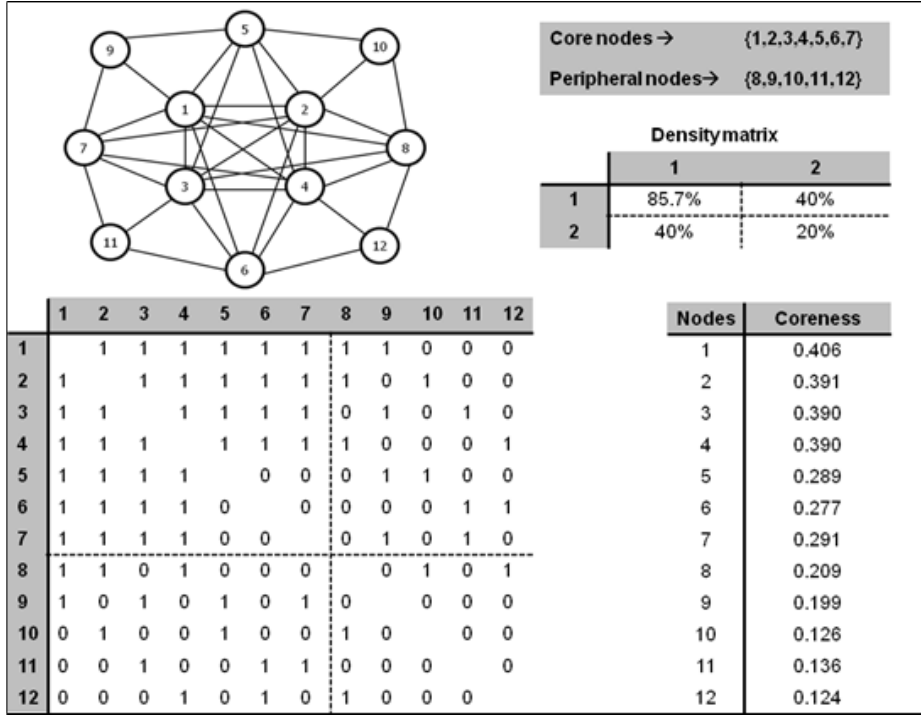
Figure 1. Visual and analytical illustration of structural cohesion using core – periphery analysis.